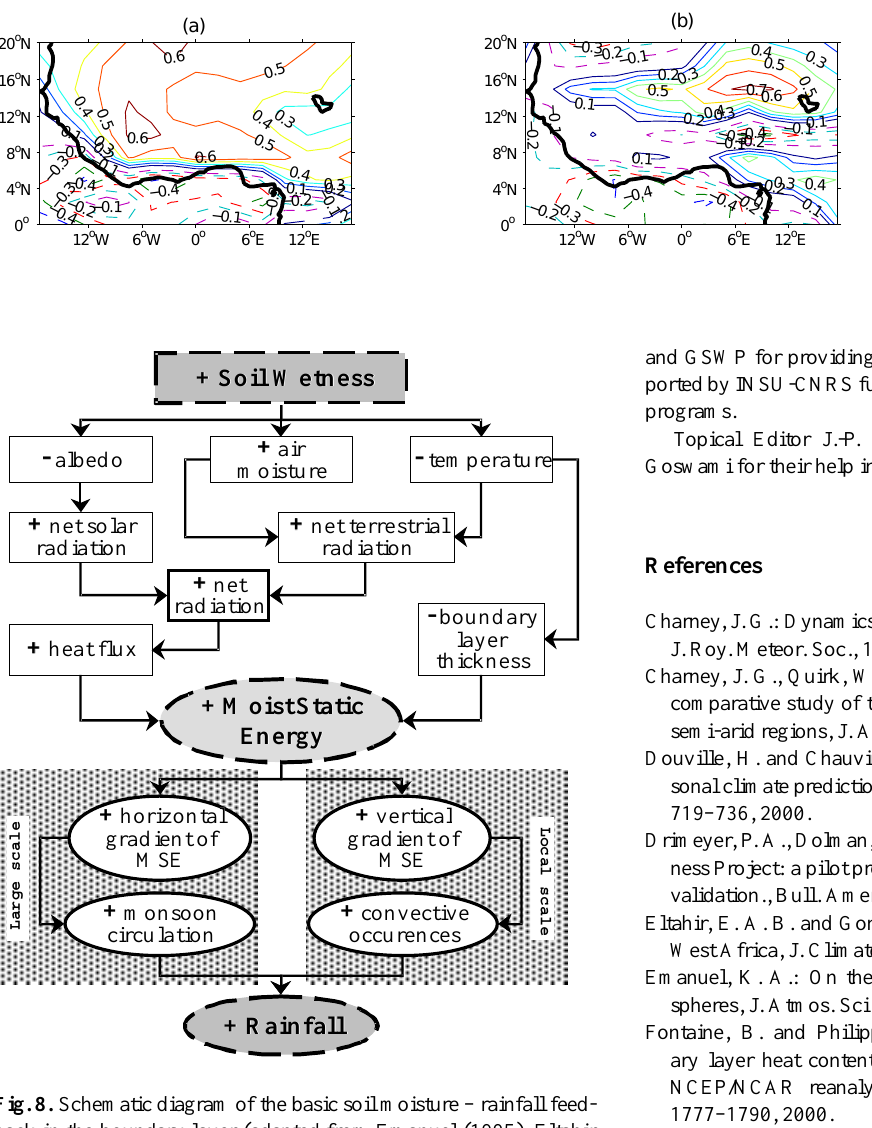
Fig. 8. Schematic diagram of the basic soil moisture – rainfall feed- back in the boundary layer (adapted from Emanuel (1995), Eltahir and Gong (1996), Zheng and Eltahir (1998), and our